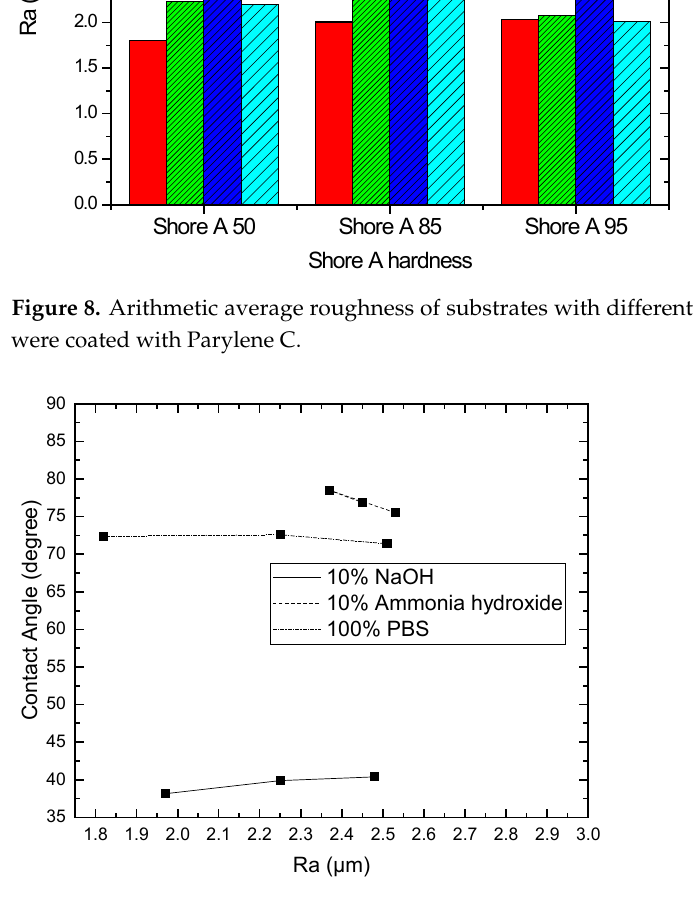
Figure 9. Contact angles of distilled water on Parylene C coated on a substrate with a Shore A hard- ness of 50 soaked in different solutions.